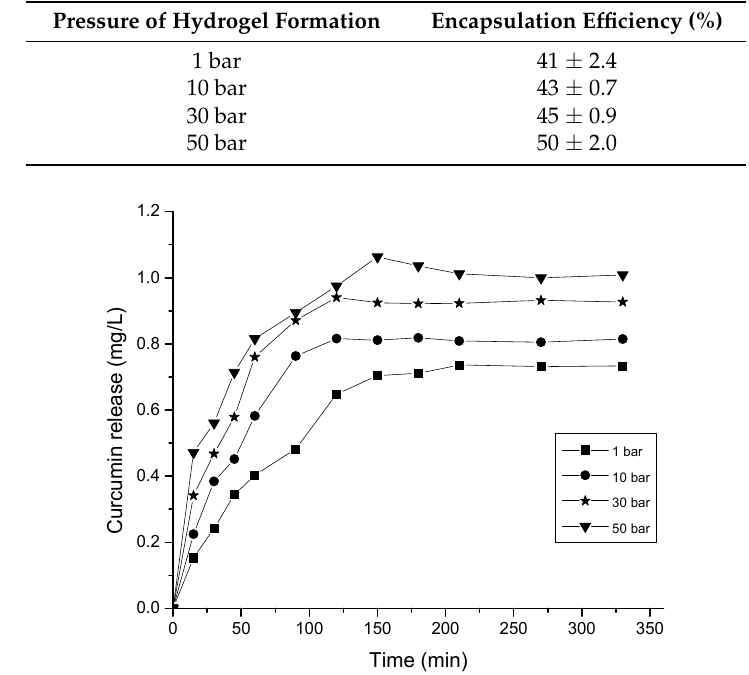
Figure 8. Curcumin release from hydrogel formed at different pressure conditions.